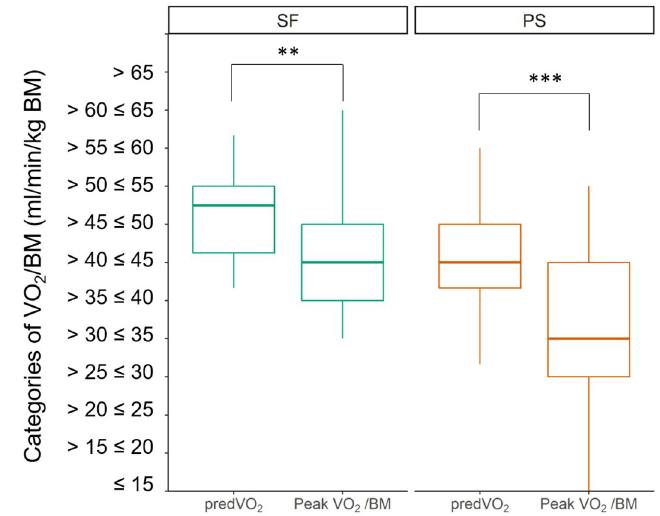
Fig 3. Differences between predVO 2 and Peak VO 2 /BM. Significant differences of means between the calculated Peak VO 2 (predVO 2 ) and in PS and SF at t 0 (first examination). In both groups the measured values were significantly below the values predicted for the time before infection. �� p < 0.01, ��� p <